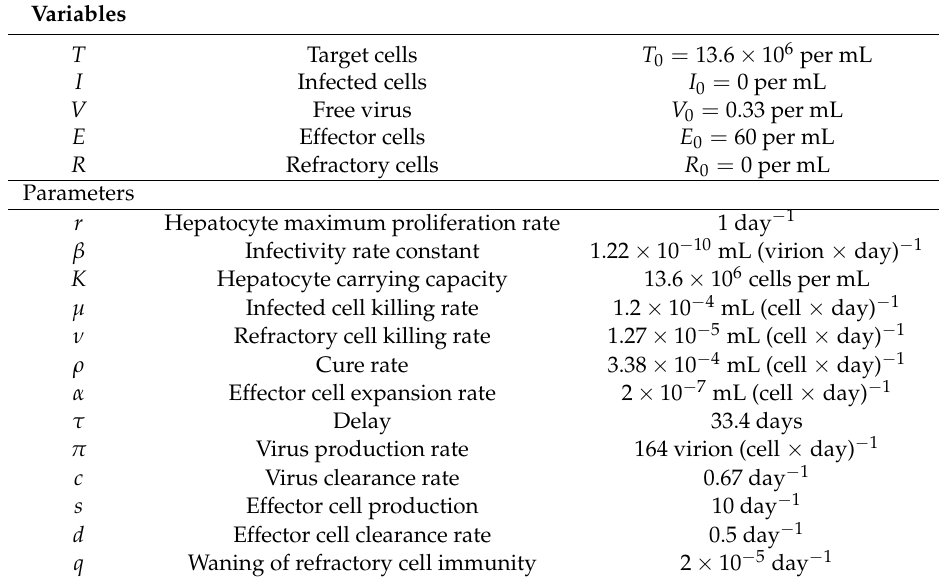
Table 1. Variables, parameters and values used in simulations with mililiter (mL) and day (d).